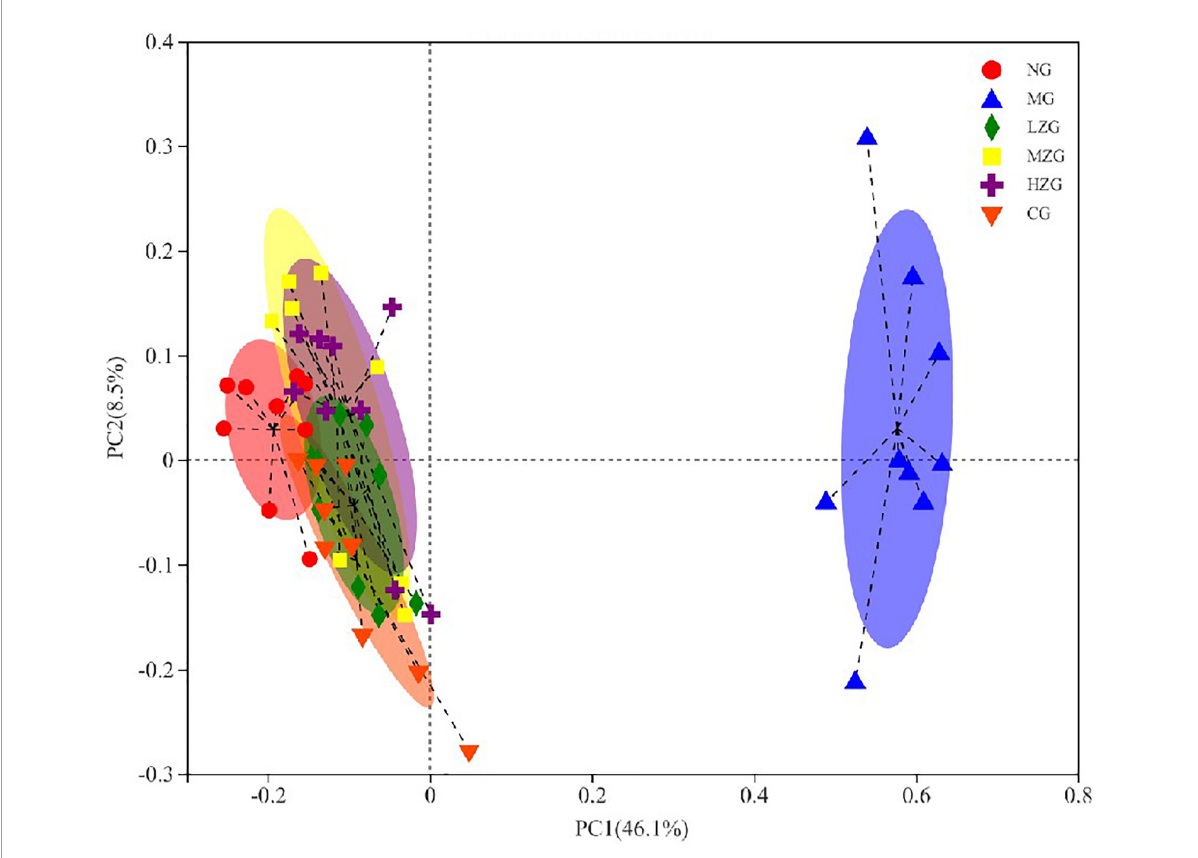
FIGURE9 Beta diversity analysis of the gut microbiota (i.e., principal coordinates analysis). Points with different colors or shapes represent samples in different groups. The closer the two sample points are, the more similar the species composition of the two samples is.